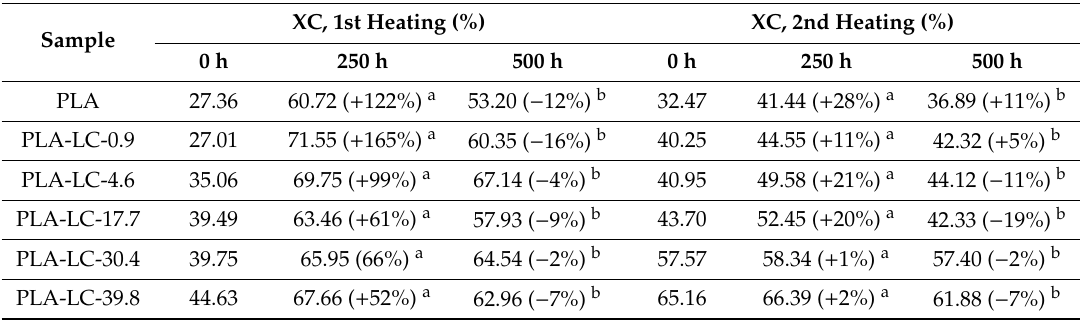
Table 2. Crystallinity (X C ) of PLA and PLA-based composites before and after the accelerated weathering